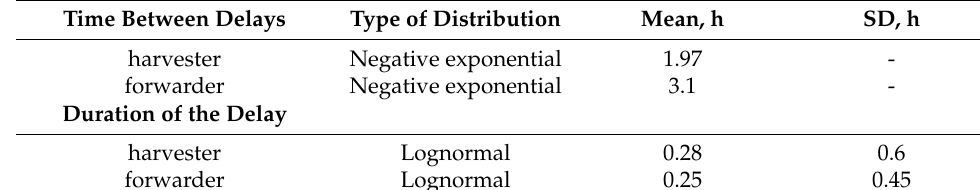
Figure 2. Productivity figures for the harvester and forwarder for the productive machine hour (PMH, E 0 ) according to the time consumption formulas used. Average removals in volume and stems in thinnings (TH) were 88 m 3 /ha and 700 stems/ha, and in regeneration cuttings (RC) were 186 m 3 /ha and 646 stems/ha. The size of load space (LS) varied between 11 and 15 m 3 . Table 4. Specifications of probability distributions used for determining other delays.